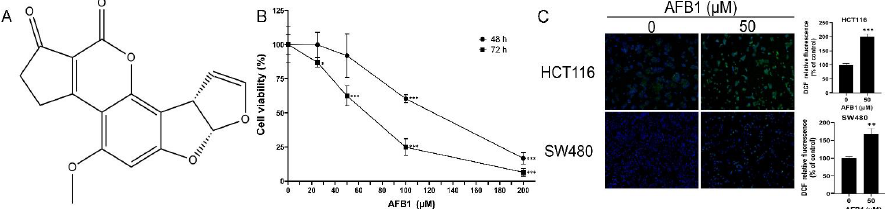
Figure 1. ( A ) The chemical structure of AFB1; ( B ) cell viability of HCT116 cells treated with AFB1; ( C ) representative fluorescence images of ROS accumulation and quantification analysis of fluo- rescence intensity. * p < 0.05, ** p < 0.01 or *** p < 0.001 indicates statistically significant difference.